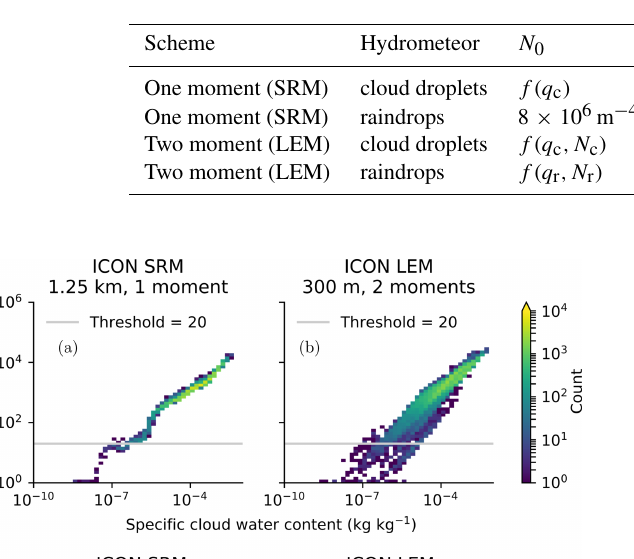
Table 1. Configuration of modified gamma distribution (Eq. 2) for liquid hydrometeors in ICON one and two-moment microphysical schemes.